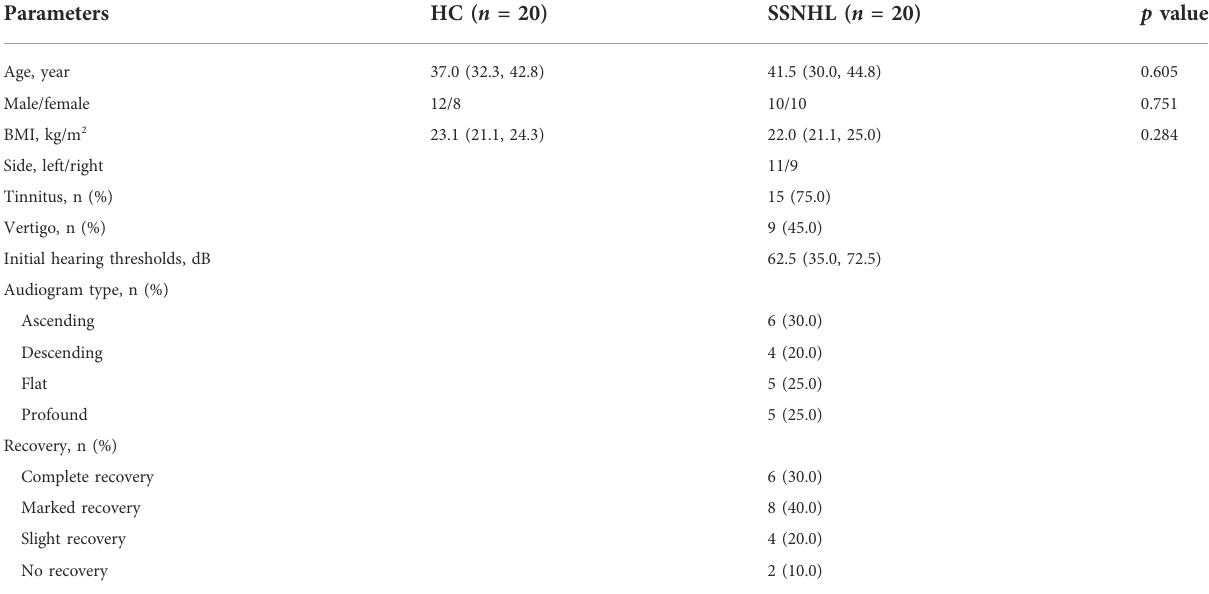
TABLE 1 Demographic and clinical parameters of HC and SSNHL patients.